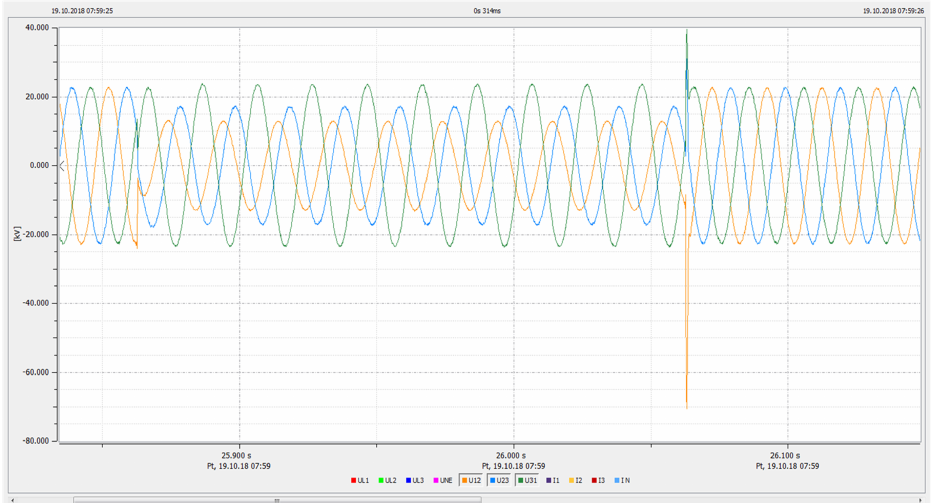
Figure 23. Waveforms of instantaneous phase-to-phase voltages values in PCC at the time of an interphase short-circuit in LOAD_1 (short-circuit between phases L1 and L2).